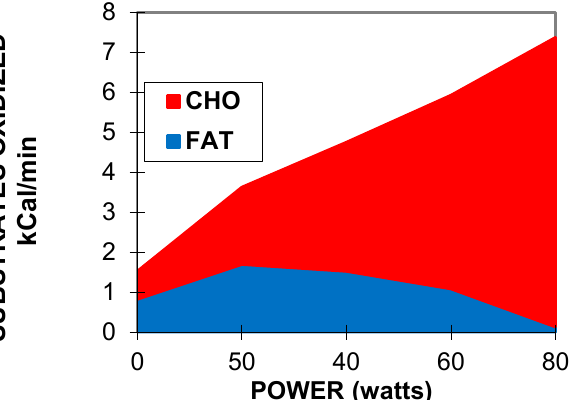
Figure 2. An example of exercise calorimetry performed on a 75-year-old male subject explored for training prescription in grade-2 obesity (weight 99.3 kg, body mass index: 36 kg/m², percentage of fat :27.7%, VO2max ACSM :19.7 mL/min/kg). Four 6-min steps were performed: 20, 40, 70, and 100 watts. The crossover point is found at 68 Watts (i.e., 56% of maximal aerobic power) and the LIPOXmax is found at 51 Watts (i.e., 42% of maximal aerobic power). The MFO is 297 mg/min, i.e.,